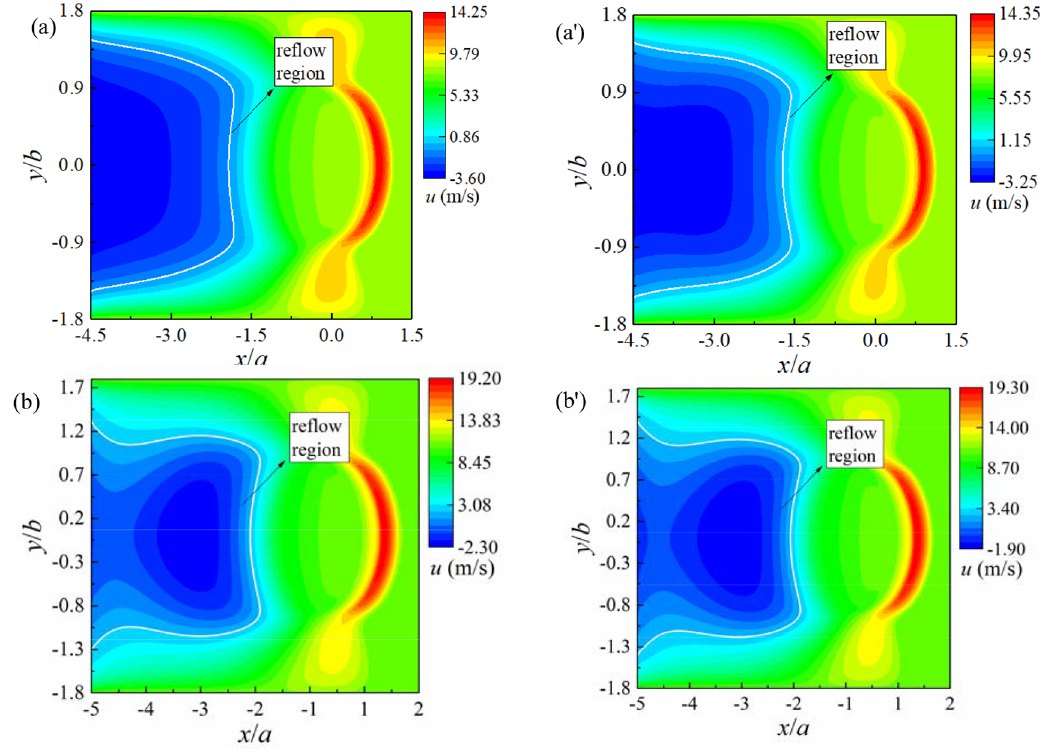
Fig. 12. Velocity fi elds at varied entrainment velocity ( y =0): (a) u r =5 m/s (inertialess), (a 0 ) u r =5 m/s (inertial), (b) u r =8 m/s (inertialess), and (b 0 ) u r =8m/s (inertial).